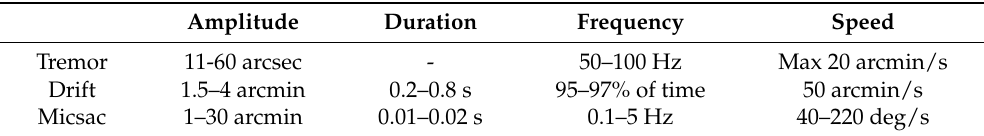
Figure 7. ( A ) An example of an eye trace taken from an AOSLO movie. A microsaccade (magenta background) is clearly distinguishable from the ocular drift (blue background). Gray vertical gridlines demarcate frame boundaries from the AOSLO movie. Each frame is acquired over 33 ms as indicated by the scale bar. ( B ) An example of an image/frame from an AOSLO movie. The cone mosaic can be resolved even at the fovea. ( C ) An example of the AOSLO raster with a green letter E as it would appear to the subject. The small discontinuities in the eye trace at the boundaries between frames 478–479 and 480–481 are likely the result of tracking errors that occur at the edges of the frame. They are infrequent and an example is included here for full disclosure. Errors like this contribute to the peaks in the amplitude spectrum at the frame rate and higher harmonics. All original eye motion traces are available for download. Adapted from [43]. Table 1. Characteristics of fixation eye movements (Adapted from [44]) with refined data from [23,43] and